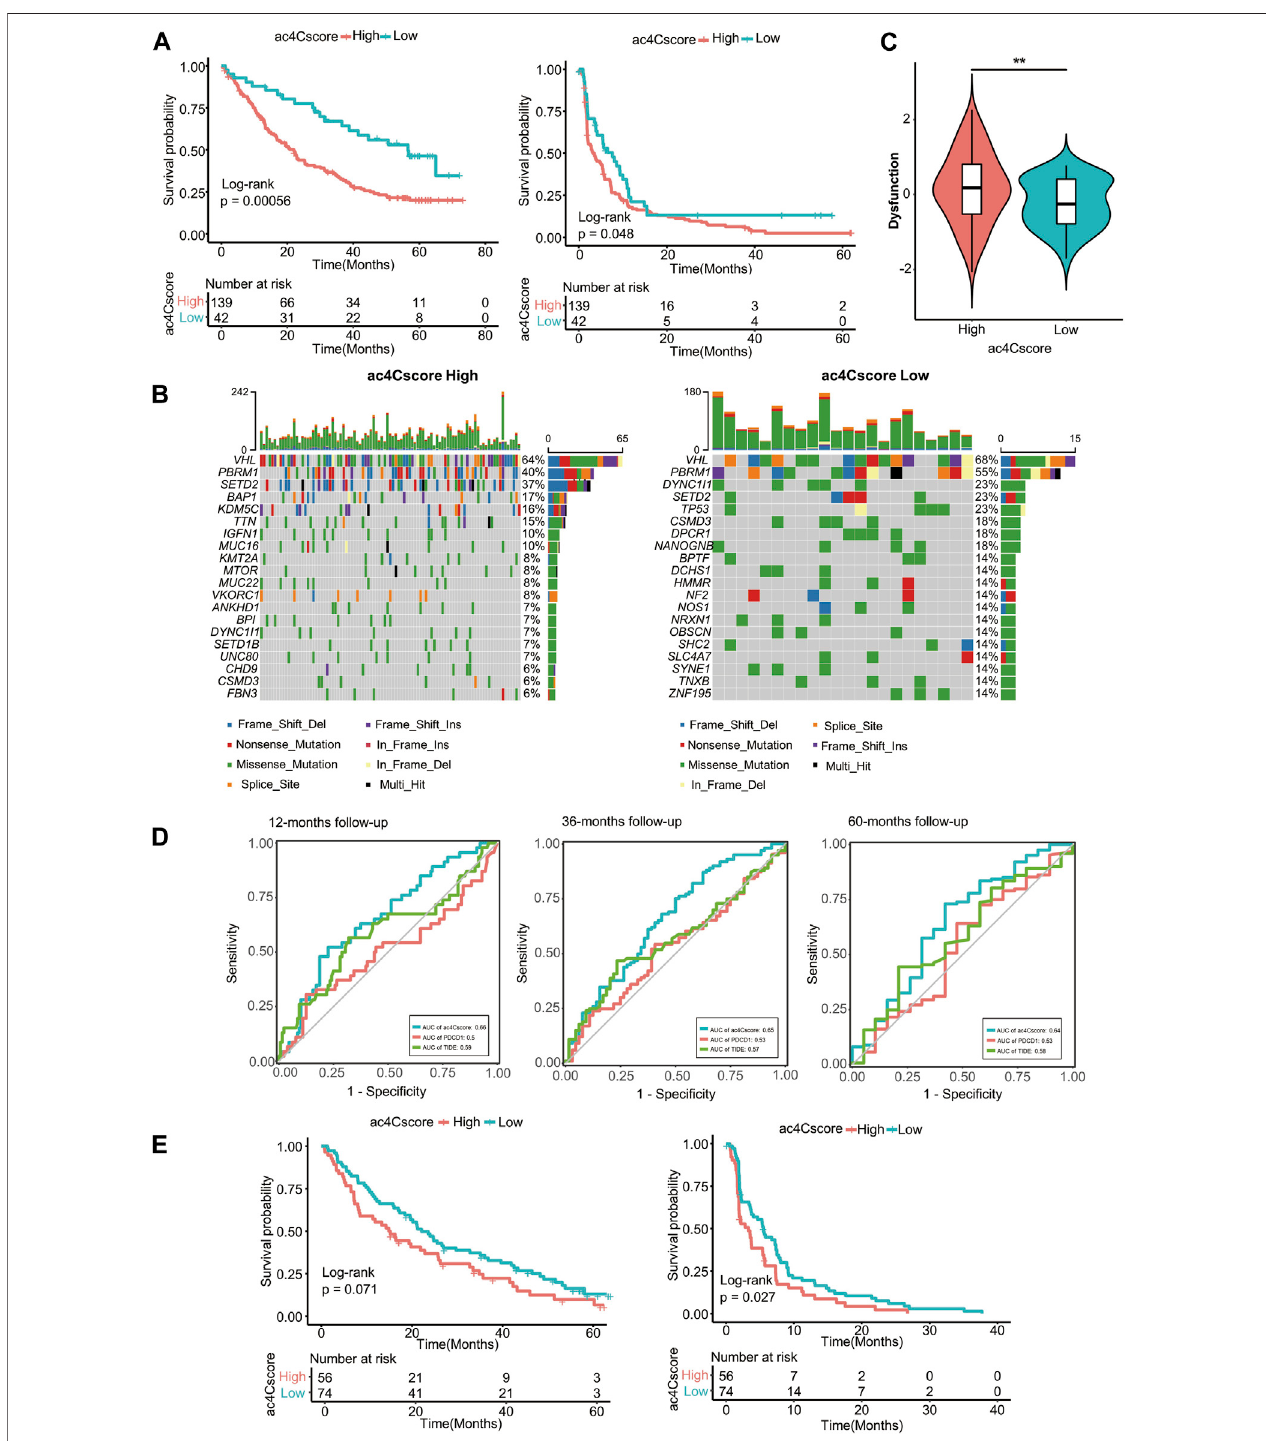
FIGURE7| ac4Cscoreisaprognosticbiomarkerinanti-PD1/mTORtreatmentcohorts. (A) Survivalanalysisforac4Cscoregroupstreatedwithanti-PD1inhibitors. Left: overall survival; Right: progression-free survival. (B) Waterfall plots depict SNVs and INDELs of patients in the anti-PD1 cohort. Left, ac4Cscore high group; Right, ac4Cscore low group. (C) The valueof thecalculated dysfunctionscore for the ac4Cscore high and low groups in theanti-PD1cohort. ** represented p < 0.01. (D) Roc curves delineating ac4Cscore and the expression of PDCD1 and TIDE on the overall survival of the anti-PD1 cohort at the 12-, 36- and 60-month follow-ups. (E) Survival analysis for ac4Cscore groups treated with anti-mTOR inhibitors. Left: overall survival; Right: progression-free survival.